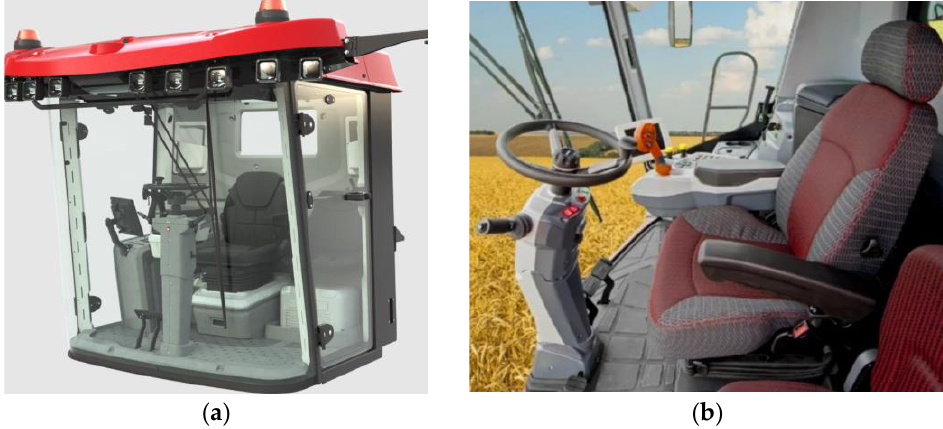
Figure 1. Combine harvester cab: ( a ) outside view and ( b ) inside view.